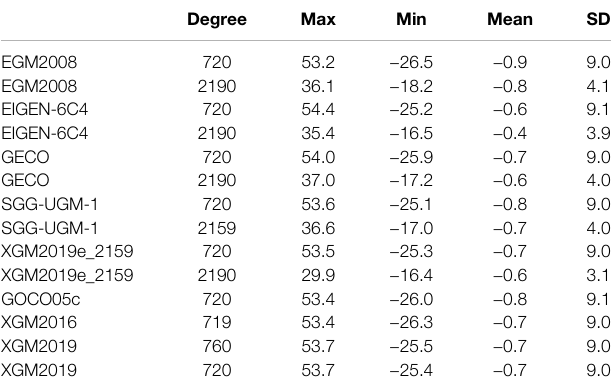
TABLE 2 | Statistics of the differences between the airborne gravity disturbances and quantities synthesized from different GGMs over the Paracel Islands (units: